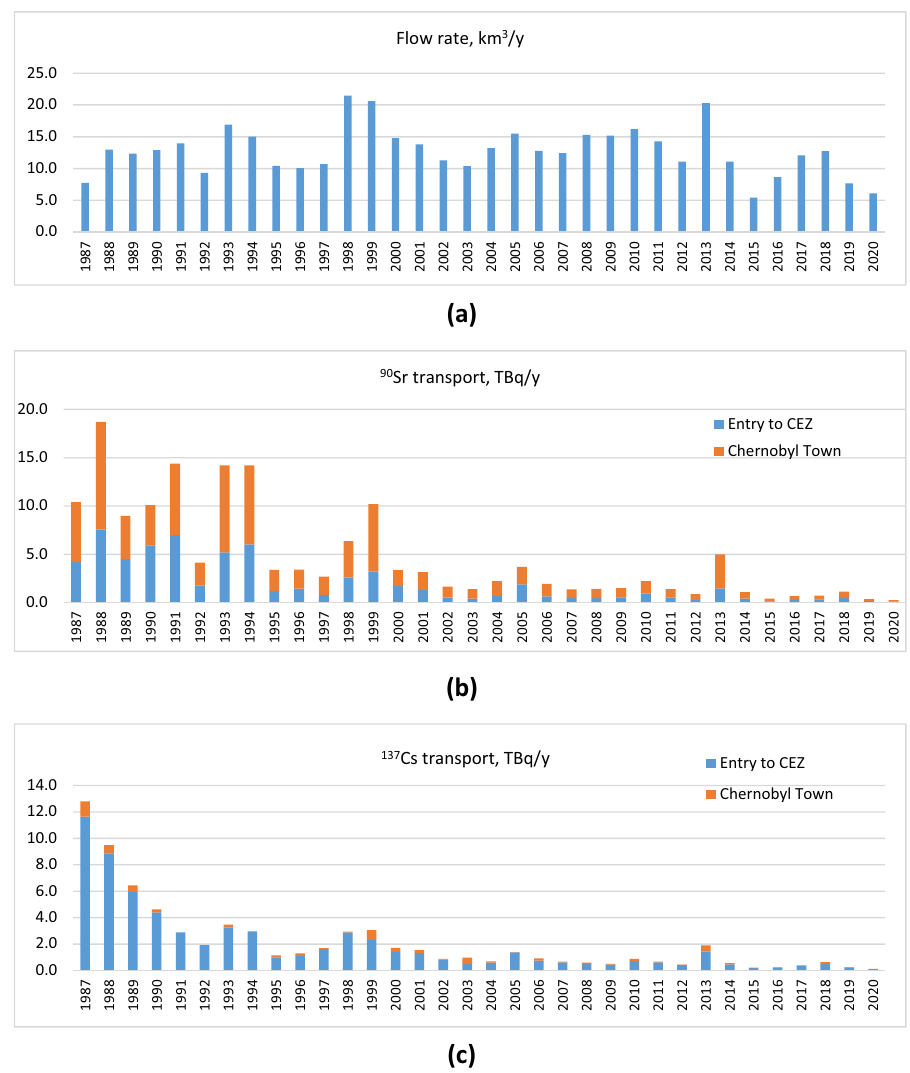
Figure 7. ( a ) Yearly water flow in the Pripyat River; ( b ), 90 Sr, and ( c ) 137 Cs budgets in the Pripyat River at